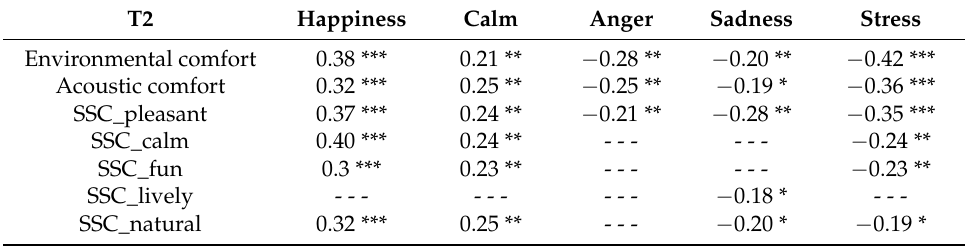
Table 5. Pearson correlations ( r ) for the four basic emotions and perceived stress at the end of the urban experience (T02), and comfort and soundscape